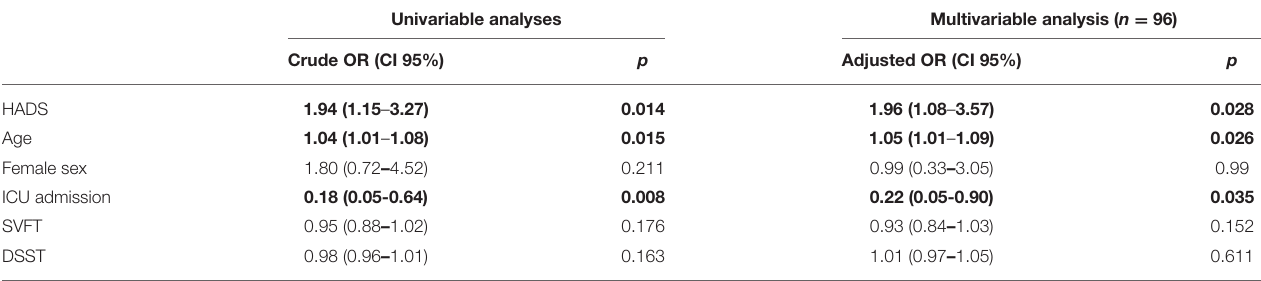
TABLE 2 | Variables associated with cognitive complaints at 1-month follow-up in logistic regression